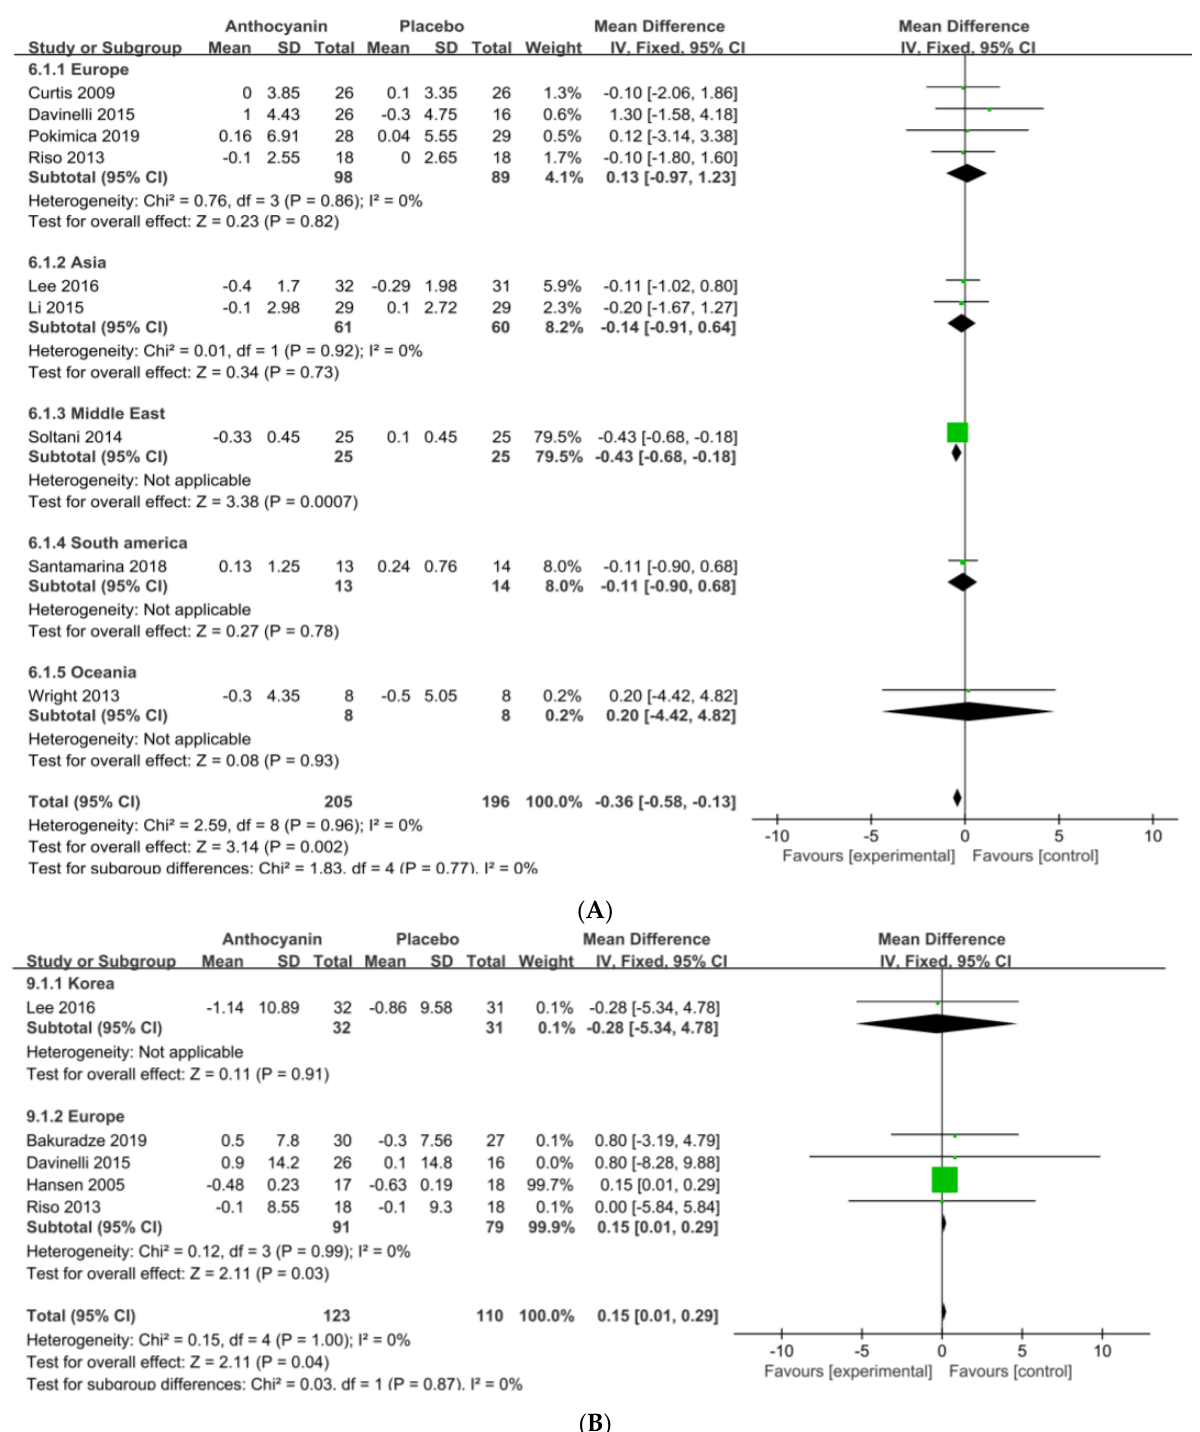
Figure 5. Forest plot of the changes of BMI ( A ) and BW ( B ) by country. Abbreviations: SD: standard deviation, CI: confidence interval, df:degrees of freedom, Statistical heterogeneity was assessed by I 2 test, Chochran's Q-test; I 2 : Higgin's I 2 test, Chi 2 : Cochran's Q-test, IV: inverse variance, Z: Z-score, P: P-value.